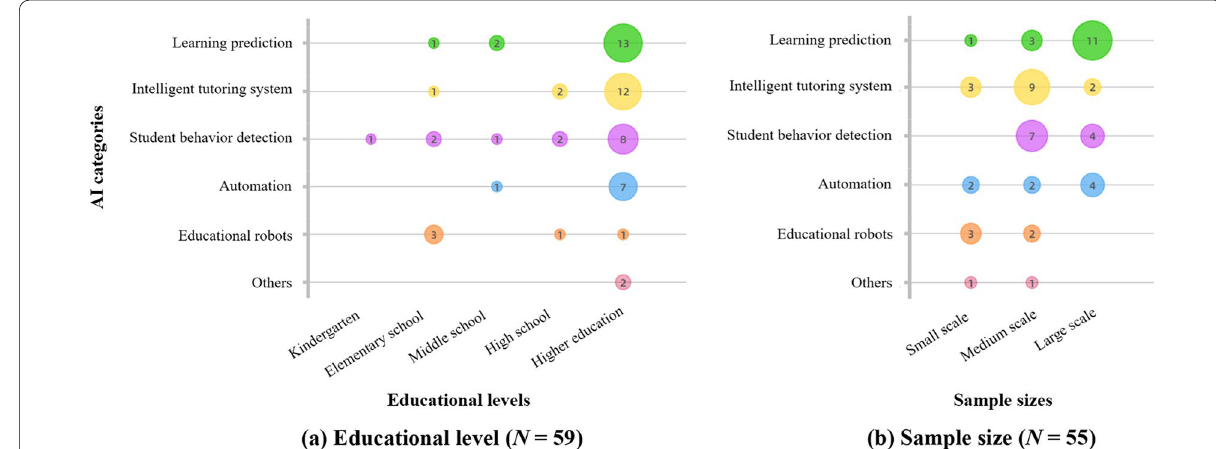
Fig. 8 AI categories under educational levels and sample sizes